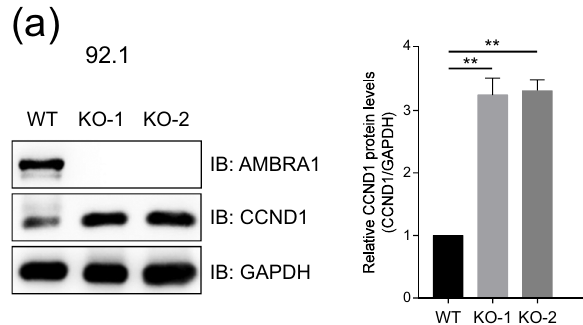
Figure A3: ( a ) The protein levels of CCND1 were upregulated in AMBRA1 knockout cells. The protein levels of AMBRA1 and CCND1 were detected by immunoblotting analysis in wild type and AMBRA1 knockout 92.1 cells. The bands of CCND1 were quanti fi ed and compared to that of GAPDH. The data are expressed as mean ± SD and were analyzed using one - way ANOVA with Tukey ’ s post - hoc test. **P < 0.01, very signi fi cantly di ff erent, the experiment was repeated three